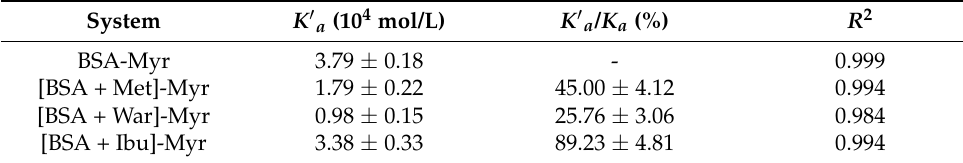
Figure 6. The binding model between BSA and Myr. ( A ) Fluorescence intensity of BSA-Myr in presence of Met, War and Ibu; pH = 7.0, T = 298K, λ ex = 280 nm. ( B ) Binding constant plots of BSA-Myr in presence of Met, War and Ibu; λ ex = 280 nm. ( C ) The lowest binding free energy pose for Myr into the BSA site I: 3D view cartoon presentation ( left ) and the 2D schematic view of the binding interaction ( right ). Table 2. Related thermodynamic parameters of probe